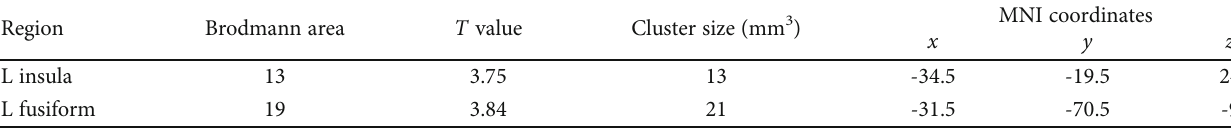
Table 3: Regions of group di ff erences in gray matter volume.